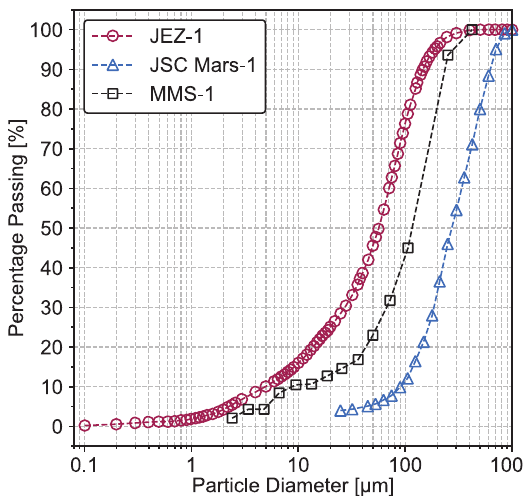
Figure 2. Grain size distribution curves of JEZ-1, JSC Mars-1 and MMS-1.